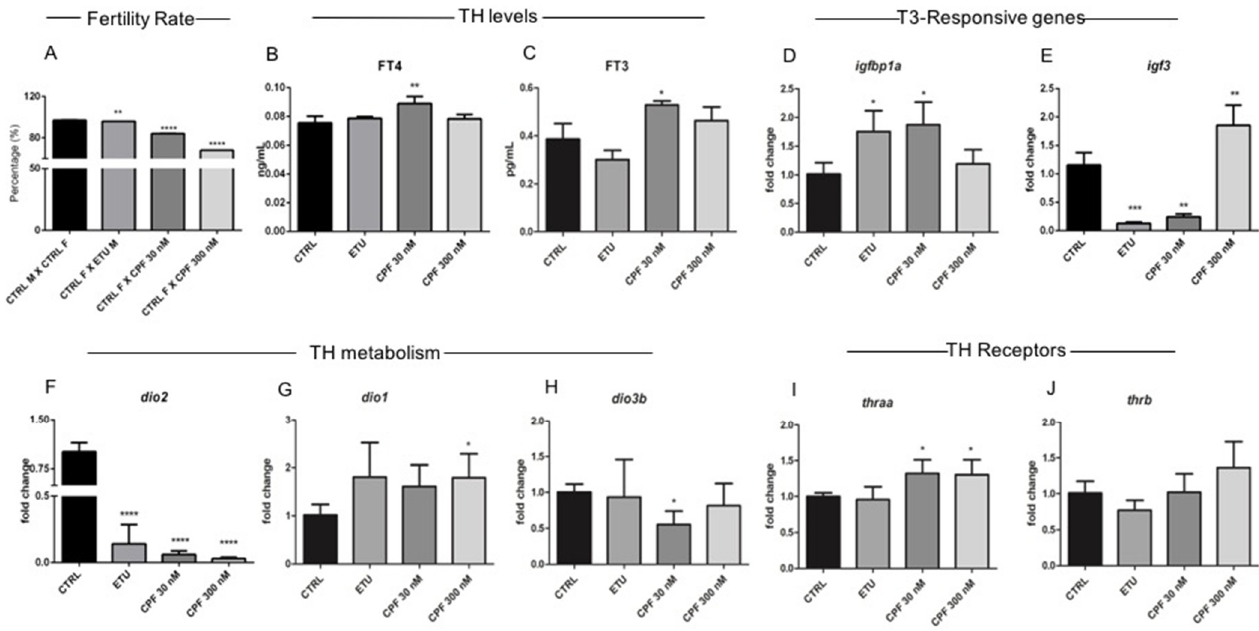
Figure 5. Zebrafish developmentally and long-life exposed to CPF and ETU exhibits male infertility and testicular hyperthyroidism. ( A ) Graph represents the fertilization percentage estimated counting the number of fertilized eggs obtained from three independent matings involving zebrafish males exposed to pesticides vs. females not exposed. ( B , C ) FT4 and FT3 levels of zebrafish adult testes (N° = 3 testis/group) measured by ELISA assay, as described in M&M section. RT-qPCR analysis of the mRNA levels of T3 responsive transcripts ( igfbp1a and igf3 ) ( D , E ); of the TH activation and inactivation enzymes ( dio2 , dio1 , and dio3b ) ( F – H ); of TH receptors ( thraa and thrb ) ( I , J ). RT-qPCR analyses were performed on three independent experiments from zebrafish adult testes (N° = 3 testis/group). Data analysis was conducted as described in M&M section. Data are reported as fold change values calculated as a ratio between average relative gene expression in treated and control, after normalization on β -actin mRNA. Mean and standard deviation are reported. Significant difference from the control group is indicated by * p < 0.05, ** p < 0.01, *** p < 0.001. One-way ANOVA (post hoc test: Dunnett’s) was